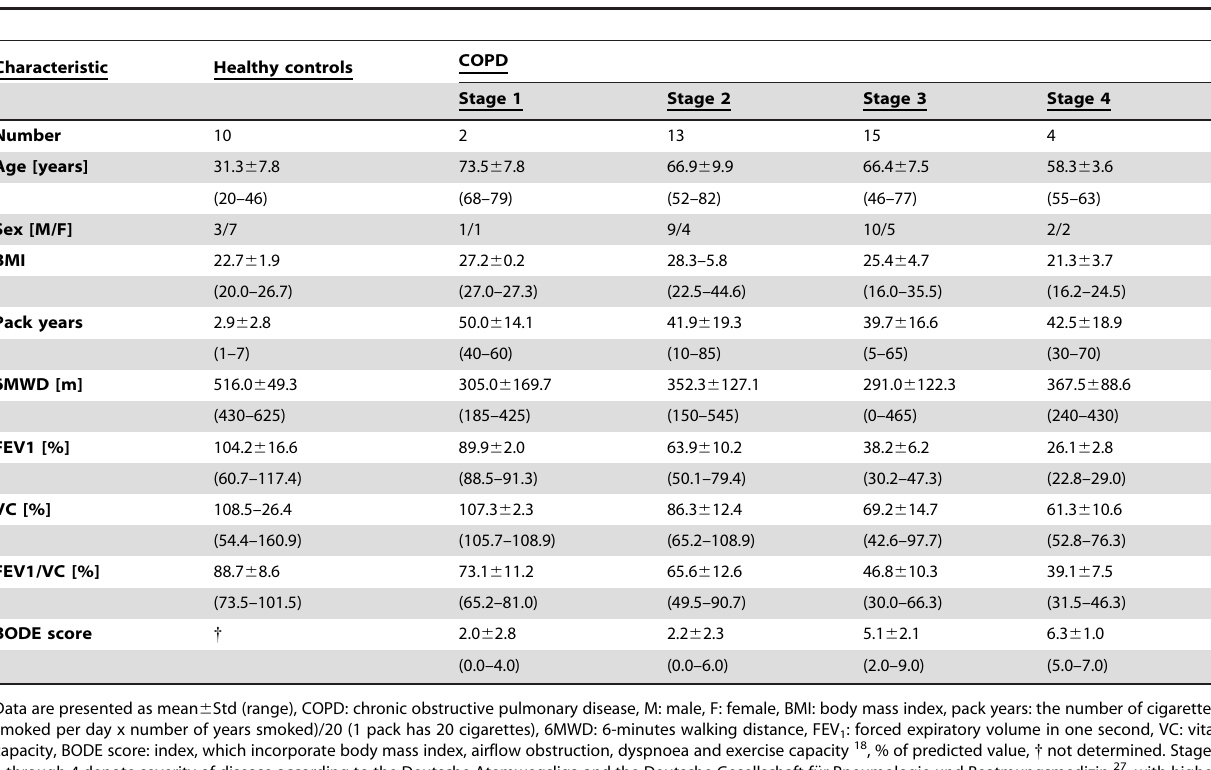
Table 1. Baseline characteristics of the study participants.